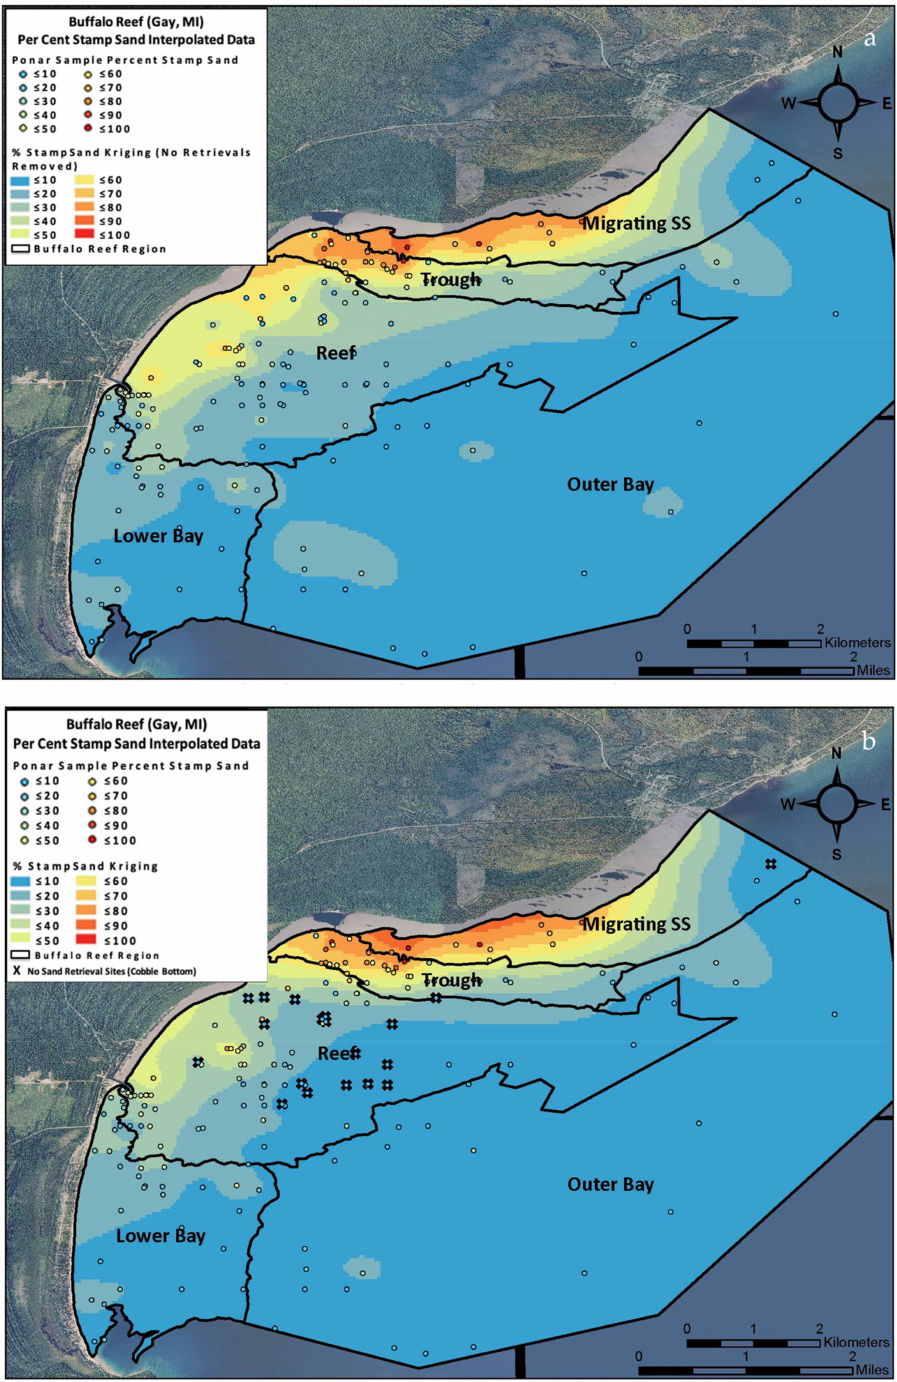
Figure 10. Percentage stamp sand (%SS) in sand mixtures across Grand (Big) Traverse Bay. Site values are in the upper left-hand legends. Contour bands are set by kernel techniques (see Methods) without (Figure 10a) and with zero values (Figure 10b) assigned to “non-retrieval” sites (black symbols). ( a ) Notice the high values occur along the shoreline from the Gay tailings pile to the Coal Dock. Values diminish in the stretch from the Coal Dock to Traverse River Seawall. Stamp sands are much less abundant along the deeper, outer edges of Buffalo Reef and in the lower bay. ( b ) Patterns are very similar, yet assignments of zero values to non-retrieval sites (black; see Methods) make contours dip more inwards toward shallow depths in northern Buffalo Reef, where the reef rises intersect the